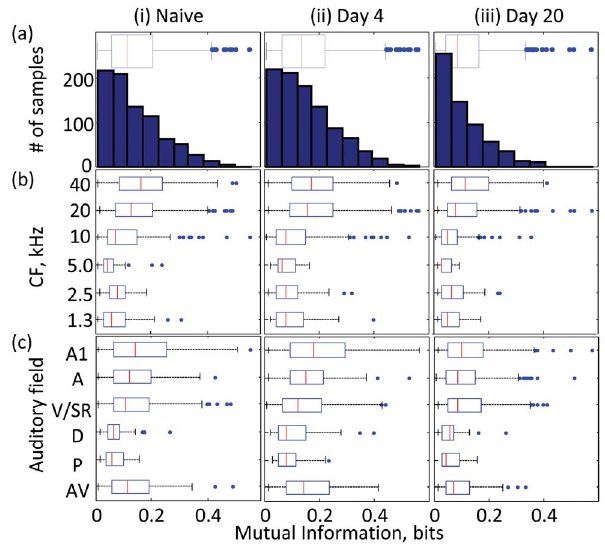
Figure 2. Distribution of mutual information. (a) Histogram of entire data: (i) naı¨ve (n=838); (ii) day 4 (n=965); and (iii) day 20 (n=618). (b) CF-dependent distribution. On each box, the central mark is the median, and the edges of the box are the 25th and 75th percentiles. The whiskers extend to the most extreme data points (maximum and minimum values) not considered outliers, which are larger than the 75th percentiles or smaller than the 25th percentiles by 1.5 times the inter-quartile range. (c) Auditory-field-dependent distri- bution. doi:10.1371/journal.pone.0068705.g002 (Fig. 5b (i); Kruskal-Wallis test, p , 1.0e-17). The threshold was lower in high-CF regions (40 kHz) than in low-CF regions (1.3 kHz) (Fig. 5c (i); two-sample Kolmogorov-Smirnov test, p , 1.0e-17). The bandwidth was narrower in high-CF regions (40 kHz) than in low-CF regions (1.3 kHz) (Fig. 5d (i); two-sample